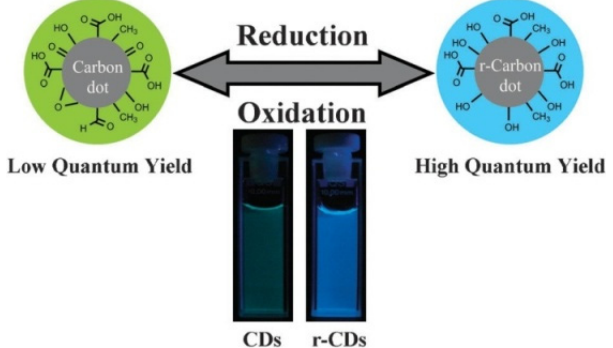
Figure 4. Graphical representation of the synthesis of reduced state carbon dots with blue luminescence from original carbon dots. Inset: photographs of aqueous solutions of the CDs ( left ) and the r-CDs ( right ) obtained under UV light (360 nm). Reprinted with the permission of Reference [73]. Copyright 2011 The Royal Society of Chemistry.